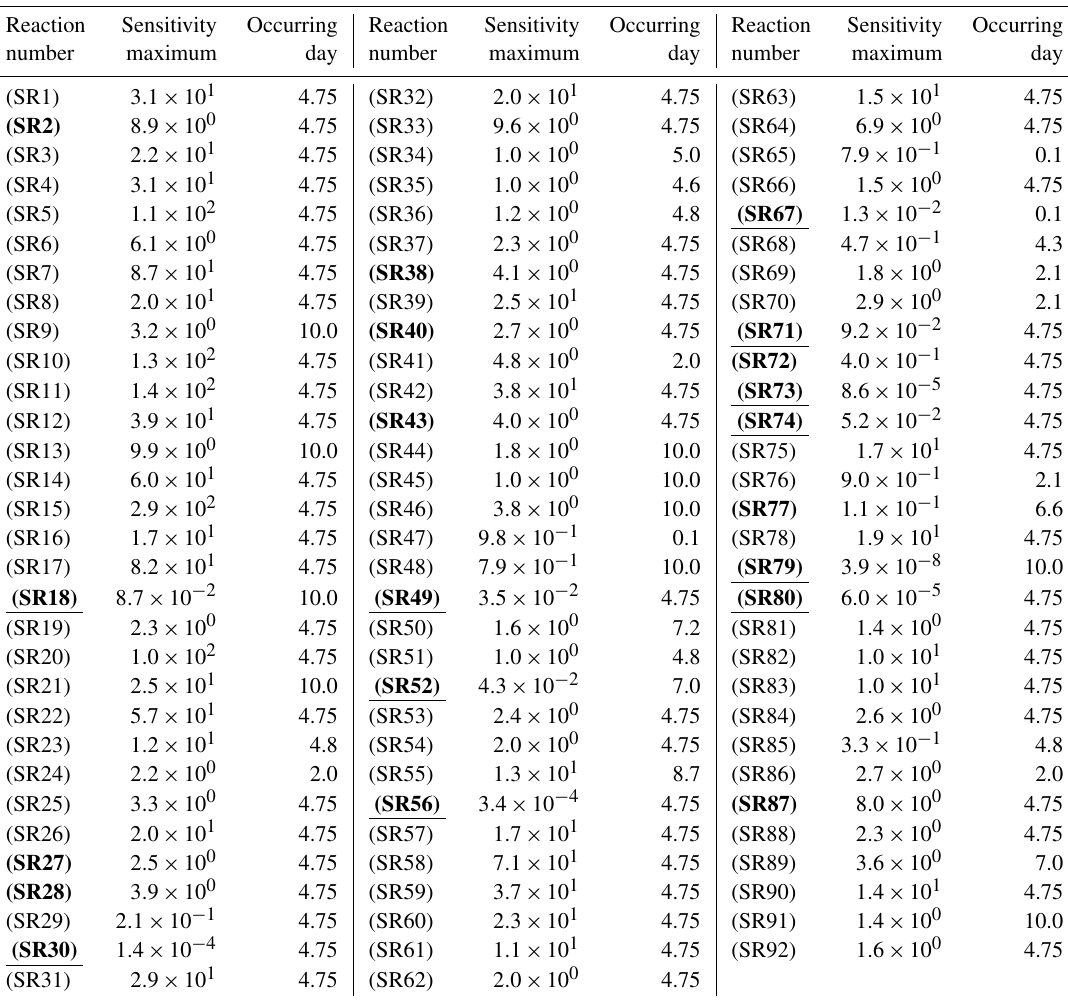
Table 3. The maximum absolute value of the concentration sensitivity coefficient for each reaction in the mechanism and the time when the maximum value occurs. Reaction number underlined denotes that this reaction is identified as unimportant via the concentration sensitivity analysis, and reaction number in bold represents that this reaction is indicated as unimportant via the principal component